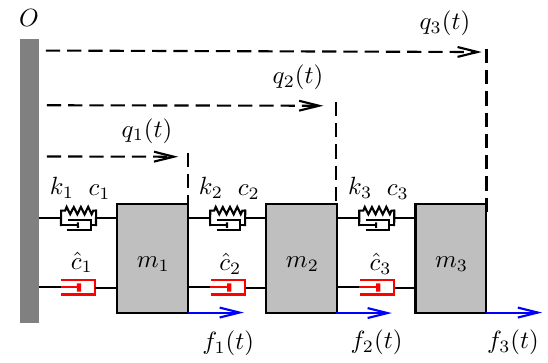
Figure 1: Mechanical system with passive dampers for vibrational response